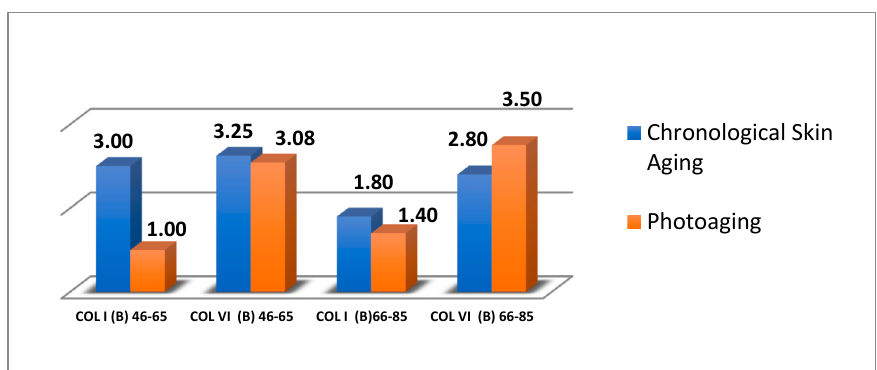
Figure 4. Average expression of C Ο L I and C Ο L VI (Index Β ) by age group and type of aging.